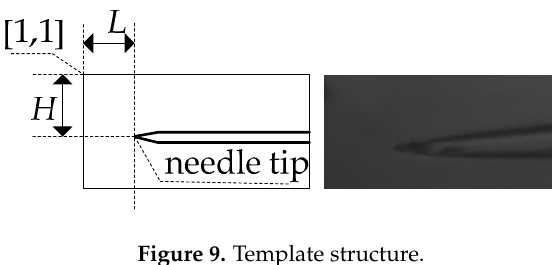
Figure 9. Template structure.